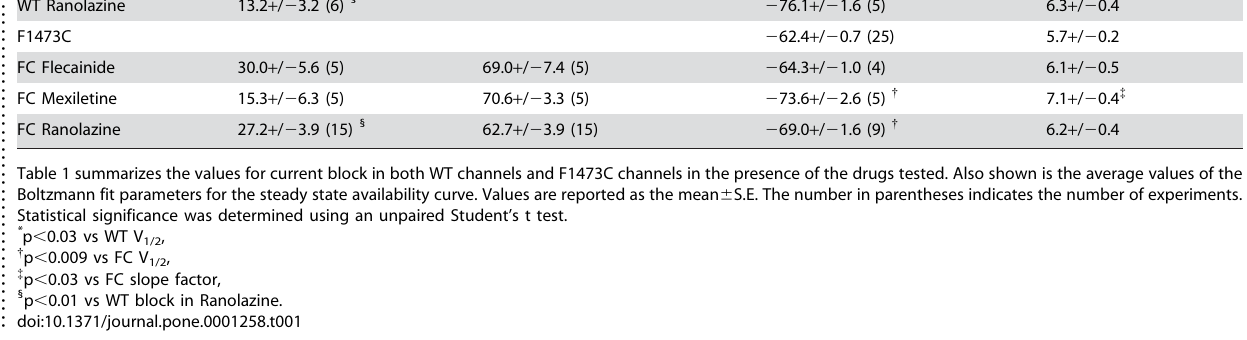
Table 1. Effects of Na + channel blockers on WT and F1473C channels. .. ... .... ... ... .... ... ... .... ... ... .... ... ... .... ... ... .... ... ... .... ... ... .... ... ... .... ... ... .... ... ... .... ... ... .... ... ... .... ... ... .... ... ... .